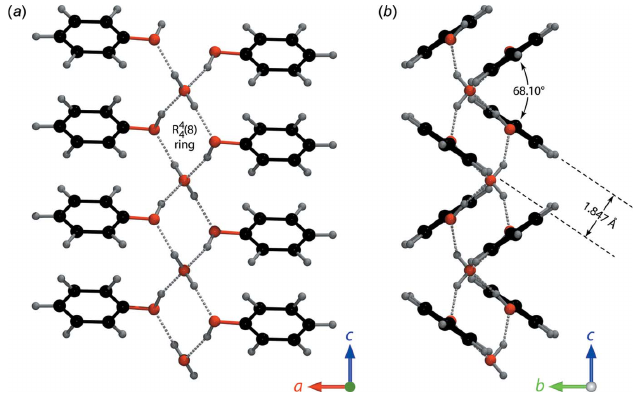
Figure 3 ( a ) The dimer shown in Fig. 2 extends as a chain parallel to the c axis. ( b ) The chain viewed parallel to the c axis reveals the offset of the phenyl rings in each dimer and the hinge angle between successive dimers along the chain.